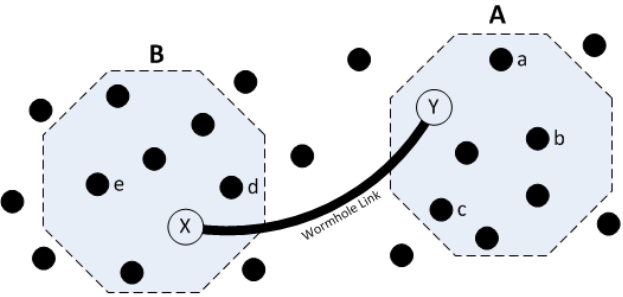
Figure 5. Wormhole attack in a wireless sensor network (WSN) [6].